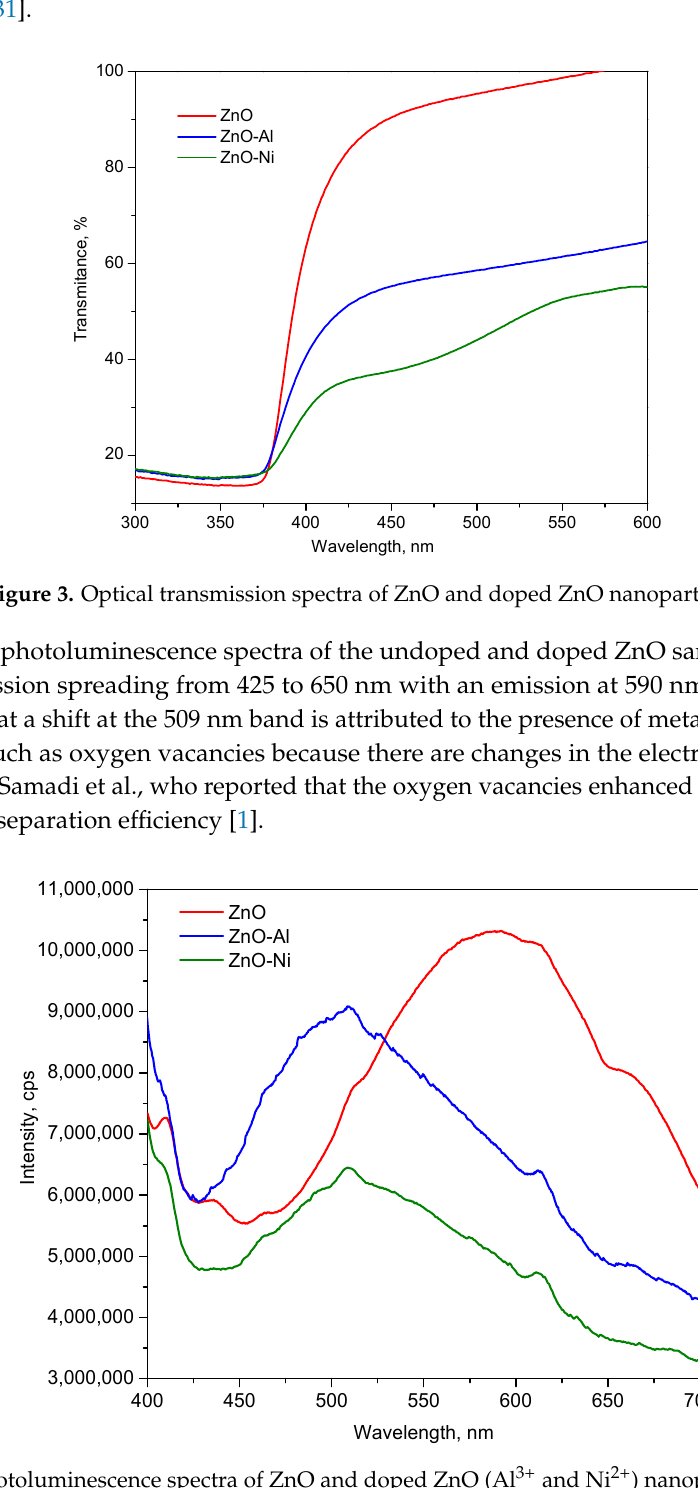
Figure 4. Photoluminescence spectra of ZnO and doped ZnO (Al 3+ and Ni 2+ ) nanoparticle samples.